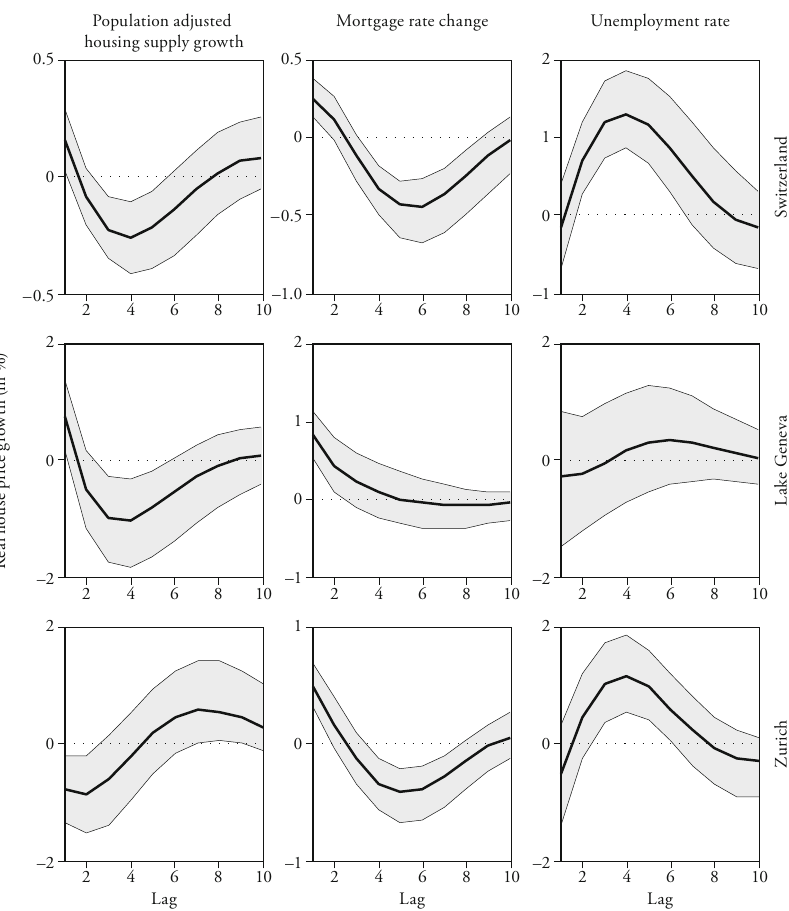
Figure 18: Regional Analysis: Response of House Prices to a Shock on